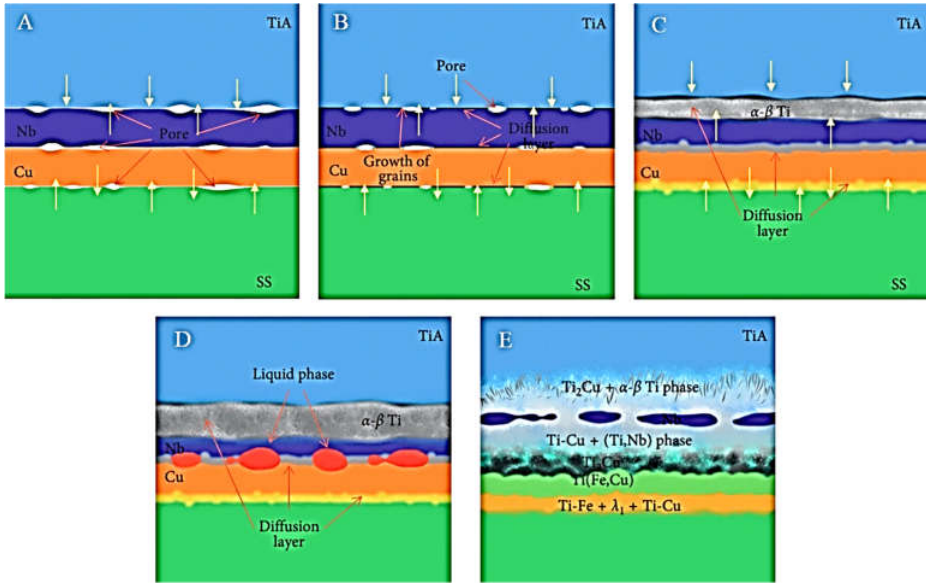
Figure 10. Formation process of titanium alloy and stainless steel diffusion-bonded joint using Cu/Nb multi-interlayer: ( A ) pores exist at the interface; ( B ) diffusion of atoms and growth of grains; ( C ) formation of α-β Ti and diffusion layers; ( D ) liquid phase formed at the interface; ( E ) formation of intermetallic compounds [25].